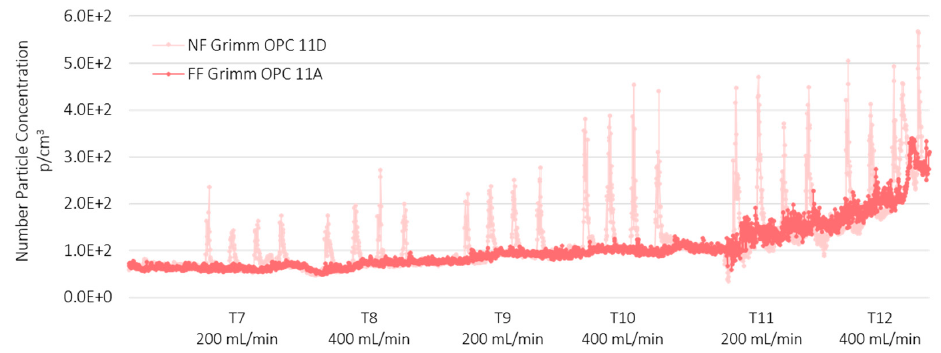
Figure 5. Comparison between particle number concentration of the AgHEC suspension at NF and FF position (light pink line) and at FF station (Red line). Particles size range 0.3–1 µm.